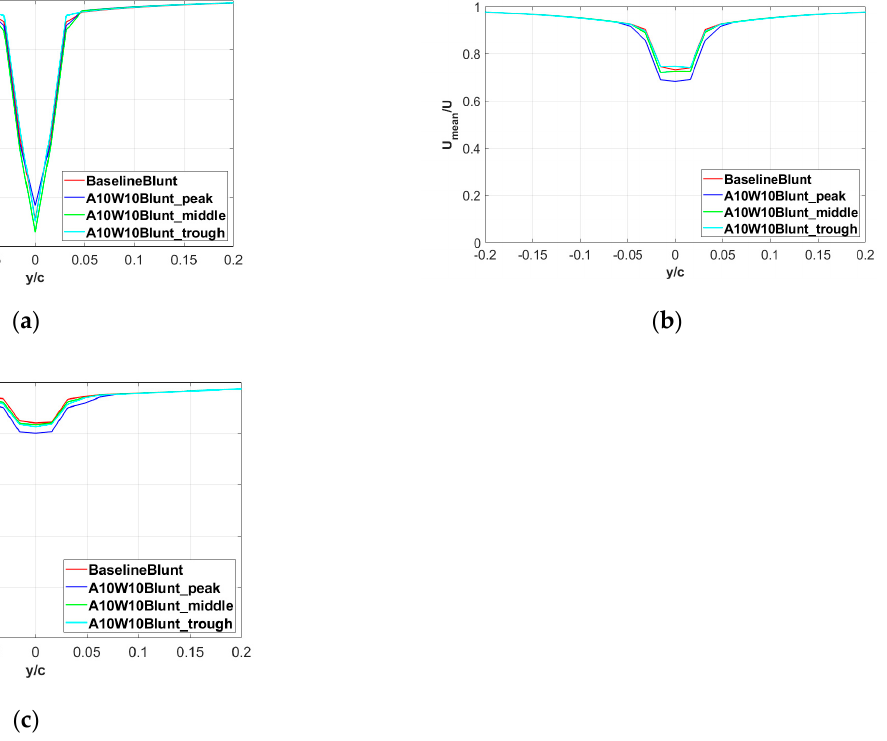
( b ) Figure 16. Streamwise vorticity distributions on several streamwise sections: ( a ) BaselineBlunt; ( b ) A10W10Blunt.